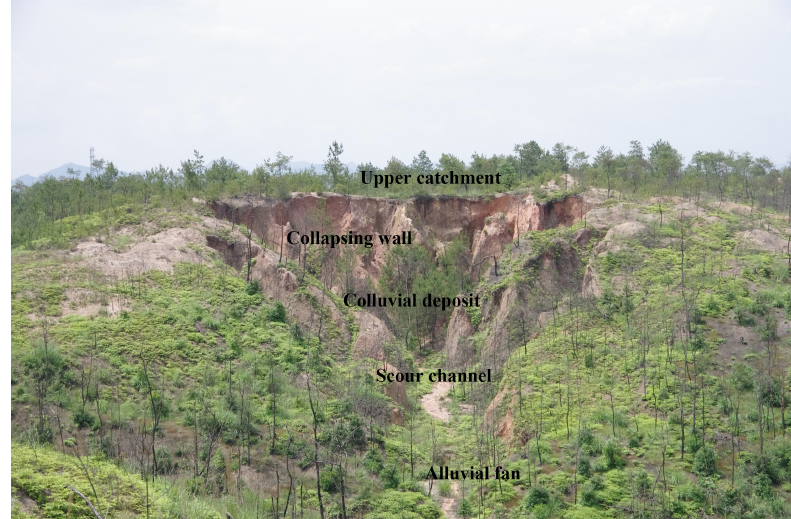
Figure 1. A typical collapsing gully in the hilly granitic region, Gan County, Jiangxi Province (photo: Yusong